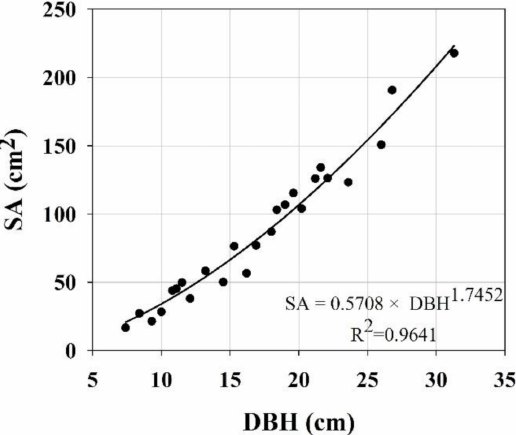
Figure 3. Plot showing the relationship between SA and DBH of the Larix gmelinii